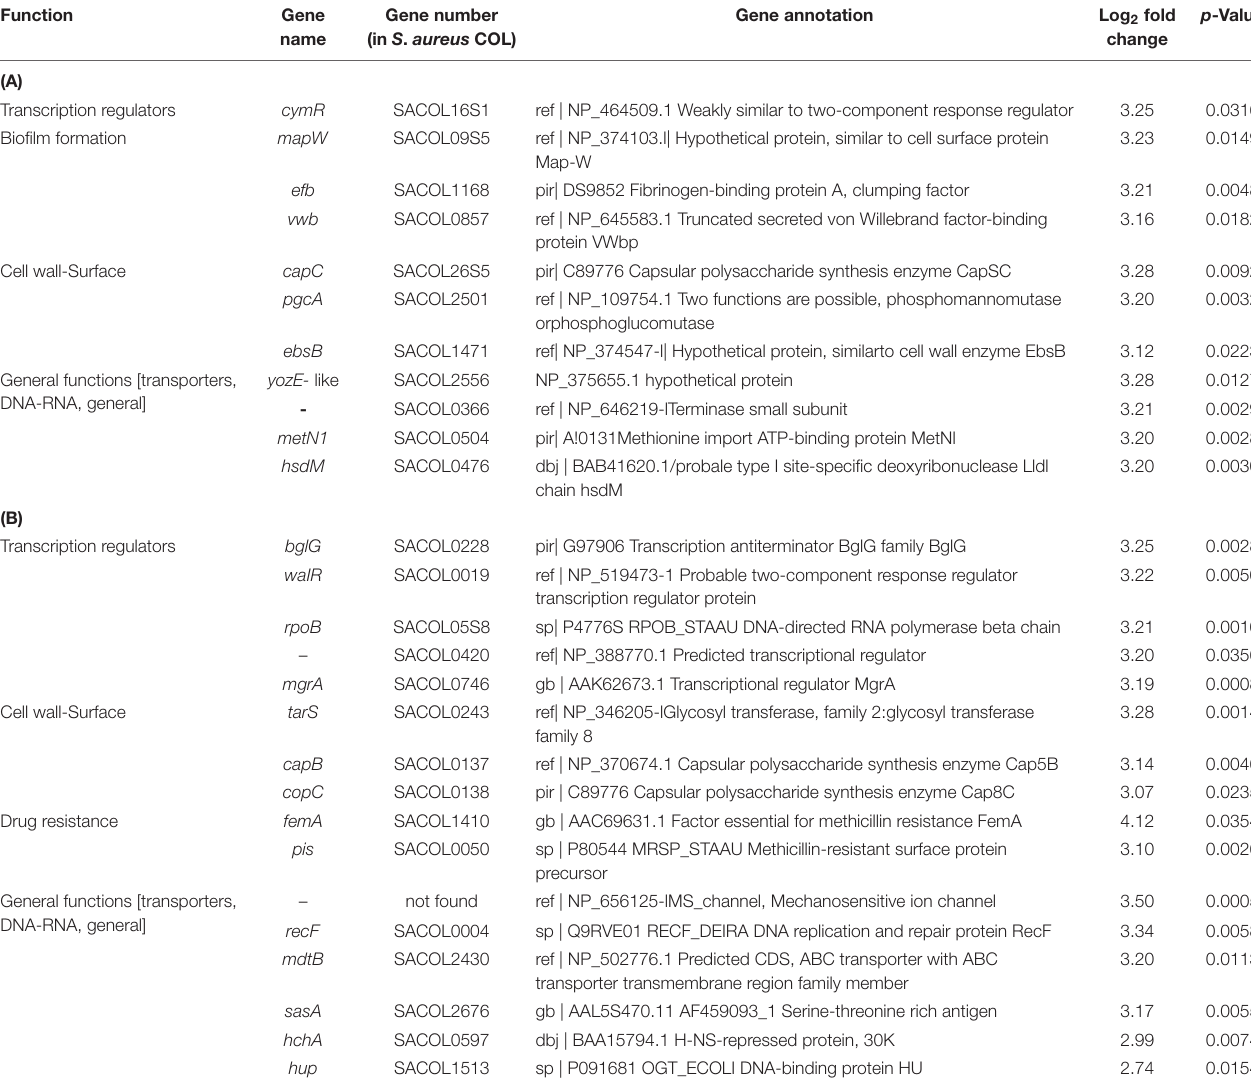
TABLE 2 | Significantly upregulated genes at pH 5 in S. aureus COL biofilm-associated (A) and planktonic cells (B) ( p < 0.05).